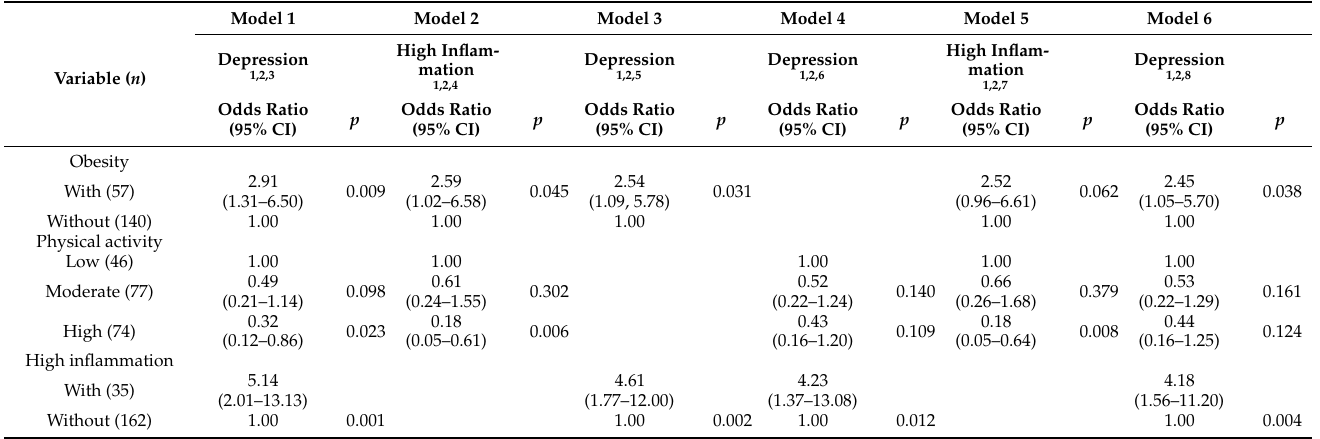
Table 3. Relationships between physical activity, obesity, inflammation, and depression using binary logistic regression